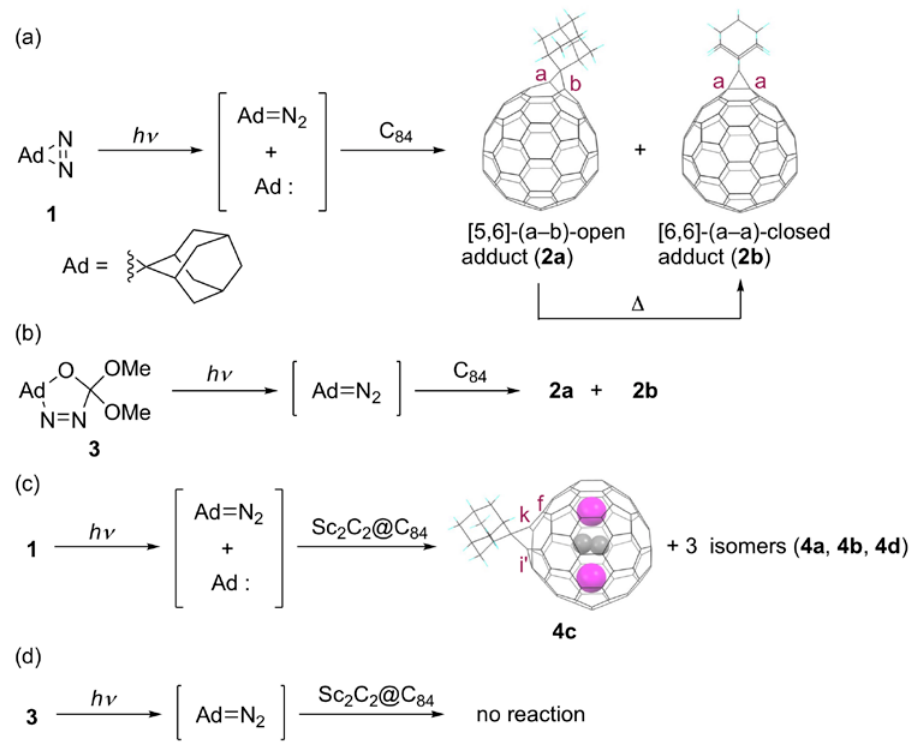
Figure 1. ( a ) Photochemical reaction of C 84 and 1 . ( b ) Photochemical reaction of C 84 and 3 . ( c ) Photochemical reaction of Sc 2 C 2 @C 84 and 1 . ( d ) Photochemical reaction of Sc 2 C 2 @C 84 and 3 .